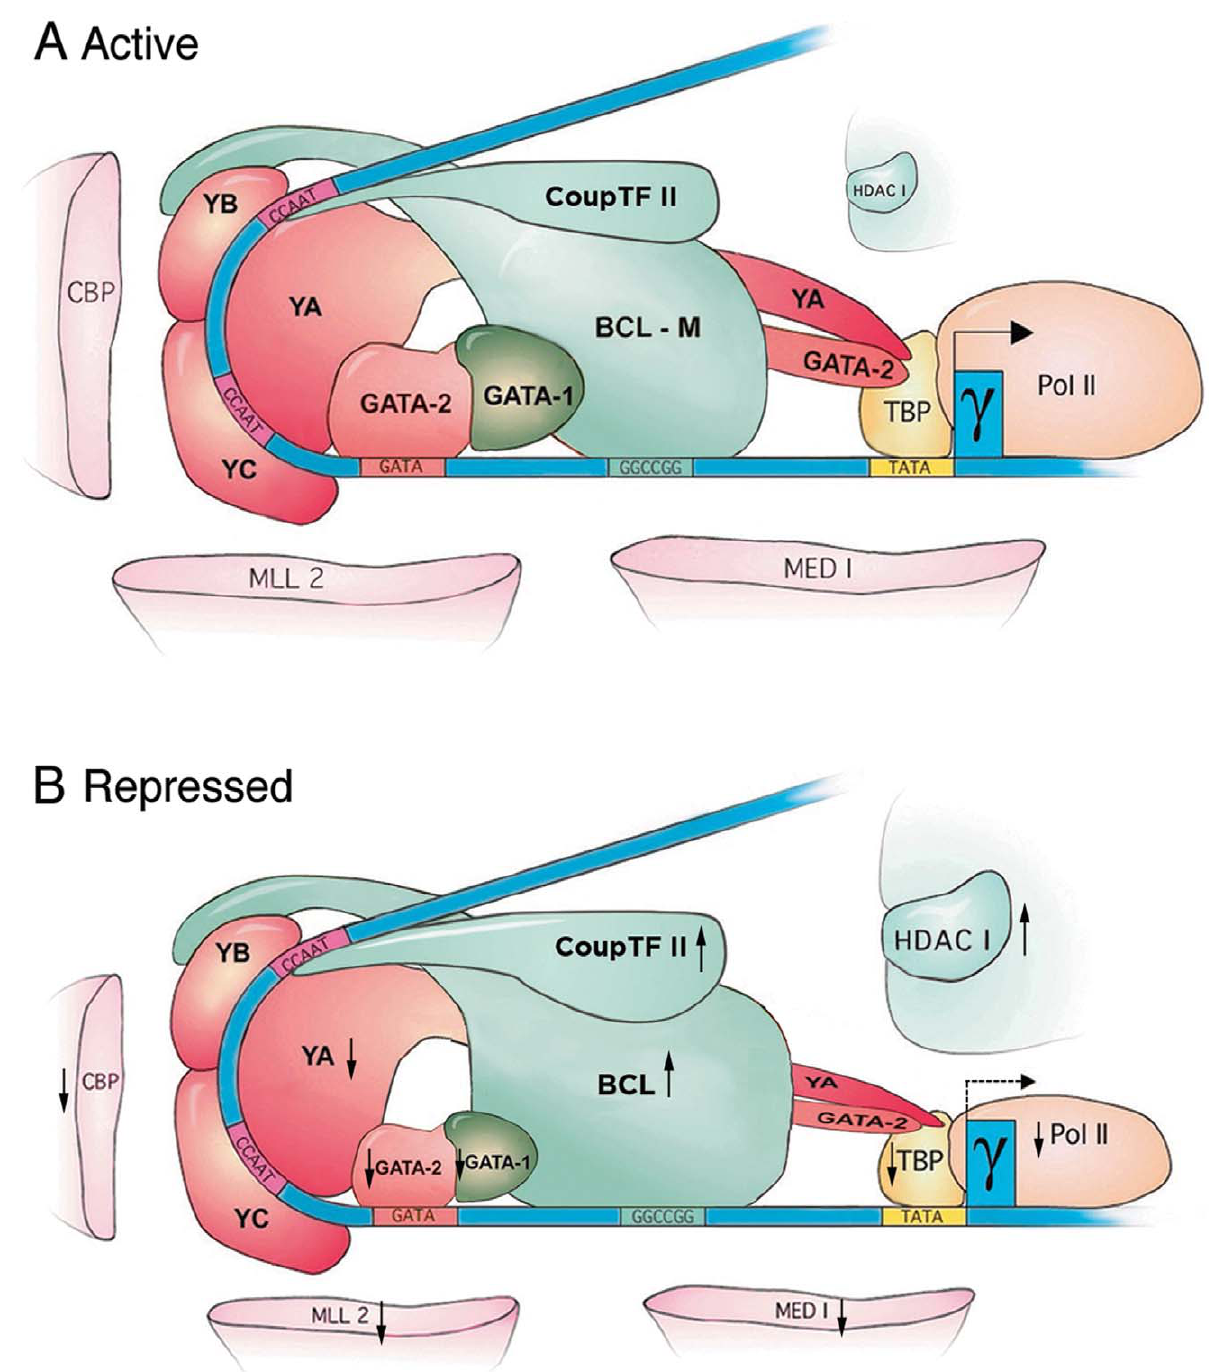
Figure 7. Models of molecular assemblies of the active and repressed proximal c -globin promoter complexes. A . Active complex. Blue ribbon: Proximal c -globin promoter DNA containing transcription activator-binding motifs, CCAAT and GATA (red bars) and the repressor-binding motif GGCCGG (green bar); blue rectangle with angled arrow: c -globin gene and transcriptional direction of c -globin mRNA. Red colored proteins: transcription activators; pink colored proteins: co-activators. Dark green and green colored proteins: transcription repressors; BCL-M: BCL11A median- isoforms expressed predominantly in human fetal and K562 erythroid cells; light green colored protein: the HDAC1 co-repressor complex. NF-Y bound at each of the tandem CCAAT motifs bends the DNA by , 70 o (3) to form the pocket for assembly of the proximal promoter complex. B. Repressed complex. Larger sizes of BCL, COUPTFII and HDAC1 complex and smaller sizes of YA, GATA-2 and -1 and the co-activators represent higher and lower levels of the respective proteins–additionally indicated also by the upward or downward arrows–in the repressed promoter complex as compared to the levels of these proteins in the active complex in A ; BCL: all sized-isoforms expressed in D14 erythroid cells (Fig. 1C); dotted angled arrow: lower transcription level of c -globin mRNA from the repressed promoter.